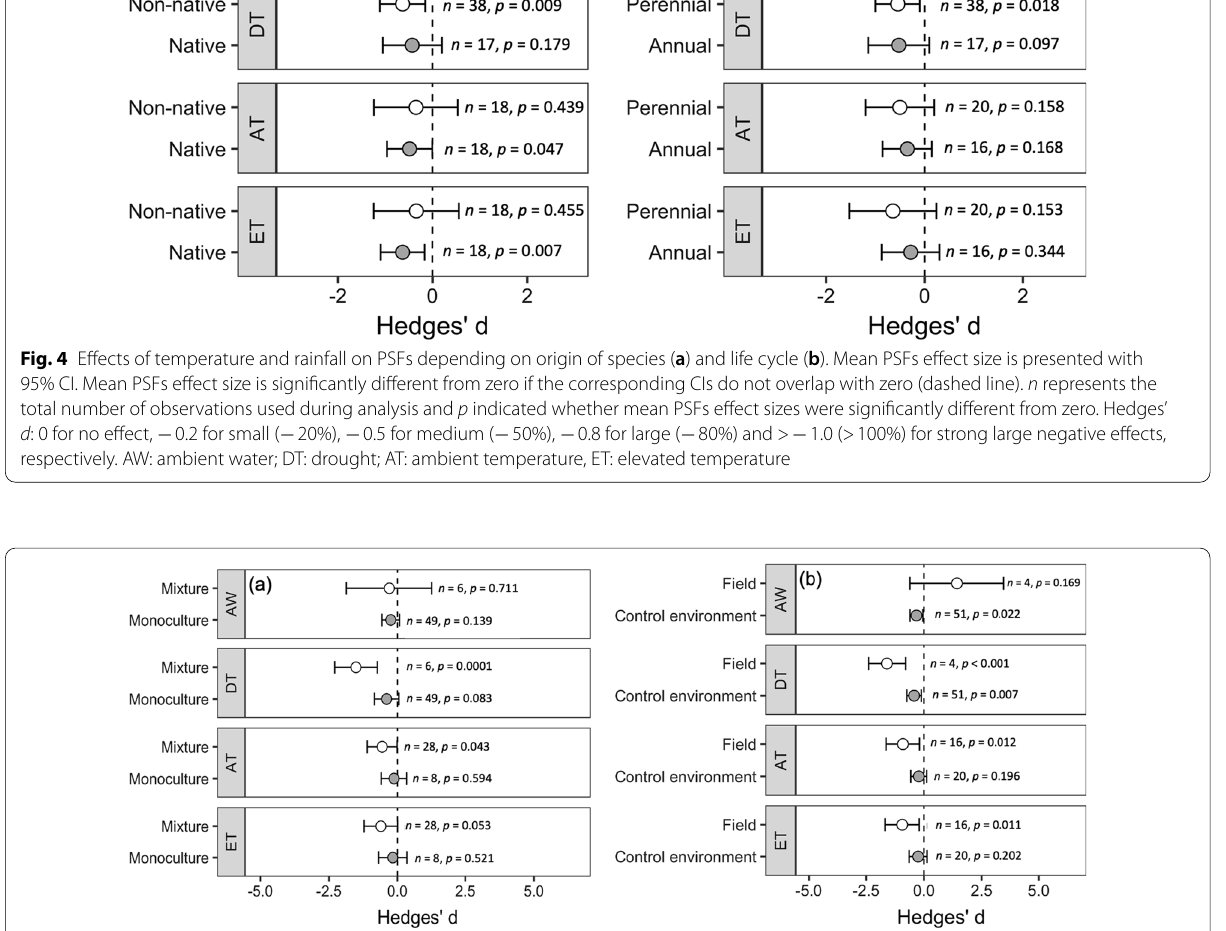
Fig. 5 Effects of temperature and rainfall on PSFs for growing condition ( a ) and experimental environment ( b ). Mean PSFs effect size is presented with 95% CIs. Mean PSFs effect size is significantly different from zero if the corresponding CIs do not overlap with zero (dashed line). n represents the total number of observations used during analysis and p indicated whether mean PSFs effect sizes were significantly different from zero. Hedges’ d : 0 for no effect, 0.2 for small ( 20%), 0.5 for medium ( 50%), 0.8 for large ( 80%) and > 1.0 (> 100%) for strong large negative − − − − − − − effects, respectively. AW: ambient water; DT: drought; AT, ambient temperature; ET: elevated